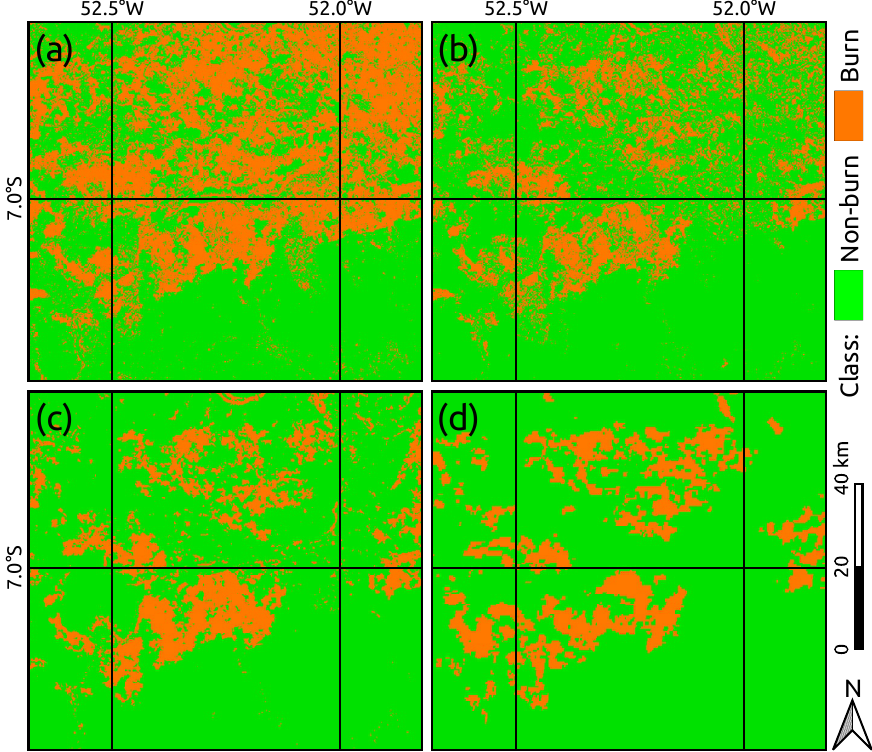
Figure 9. The NBR behavior for the reference image and individual instants regarding Area 3. Regions delimited by red rectangles highlight places with potential changes over time.